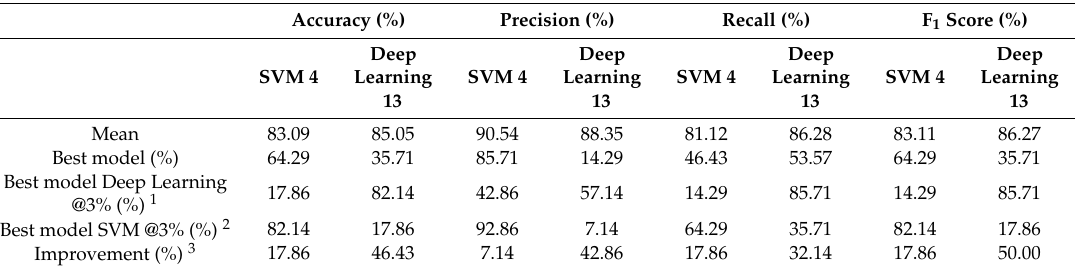
Table 4. SVM and deep-learning results.